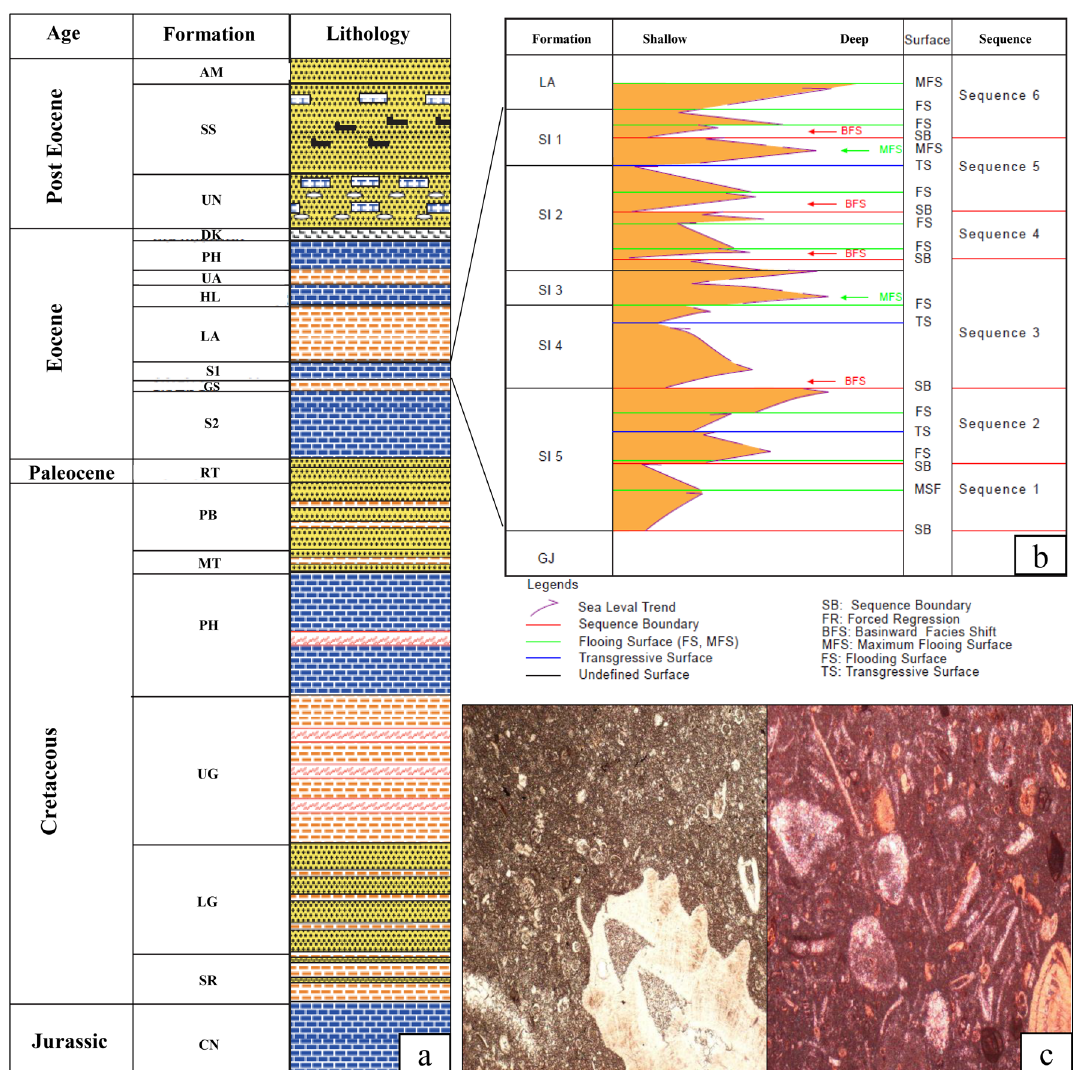
Fig. 2 a Stratigraphic column of the study area, b sequence stratig- raphy of S1 limestone and c thin section from S1 reservoir showing pelagic wackestone—probably deposited in a very low energy deep- water base-of-slope/basin-floor environment with poor fracture and